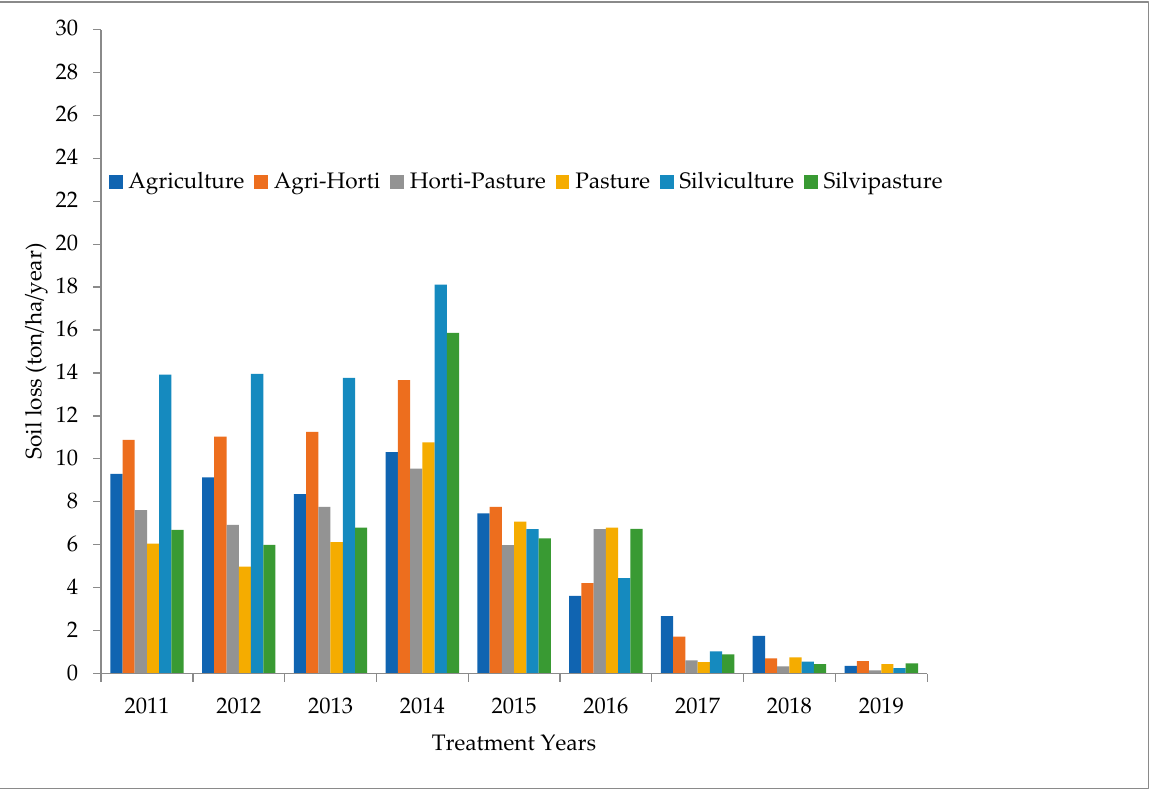
Figure 9. Impact of selected land use systems on sediment loss (ton ha − 1 year − 1 ) during the study period. T 1 —Agriculture, Glycin max ; T 2 —Agri-Horti, Manilkara achras and Glycin max ; T 3 —Horti-Pasture, Emblica officinalis and Cenchrus ciliaris ; T 4 —Pasture, Cenchrus ciliaris ; T 5 —Silviculture, Accacia nilotica ; T 6 —Silvipasture, Accacia nilotica and Cenchrus ciliaris.